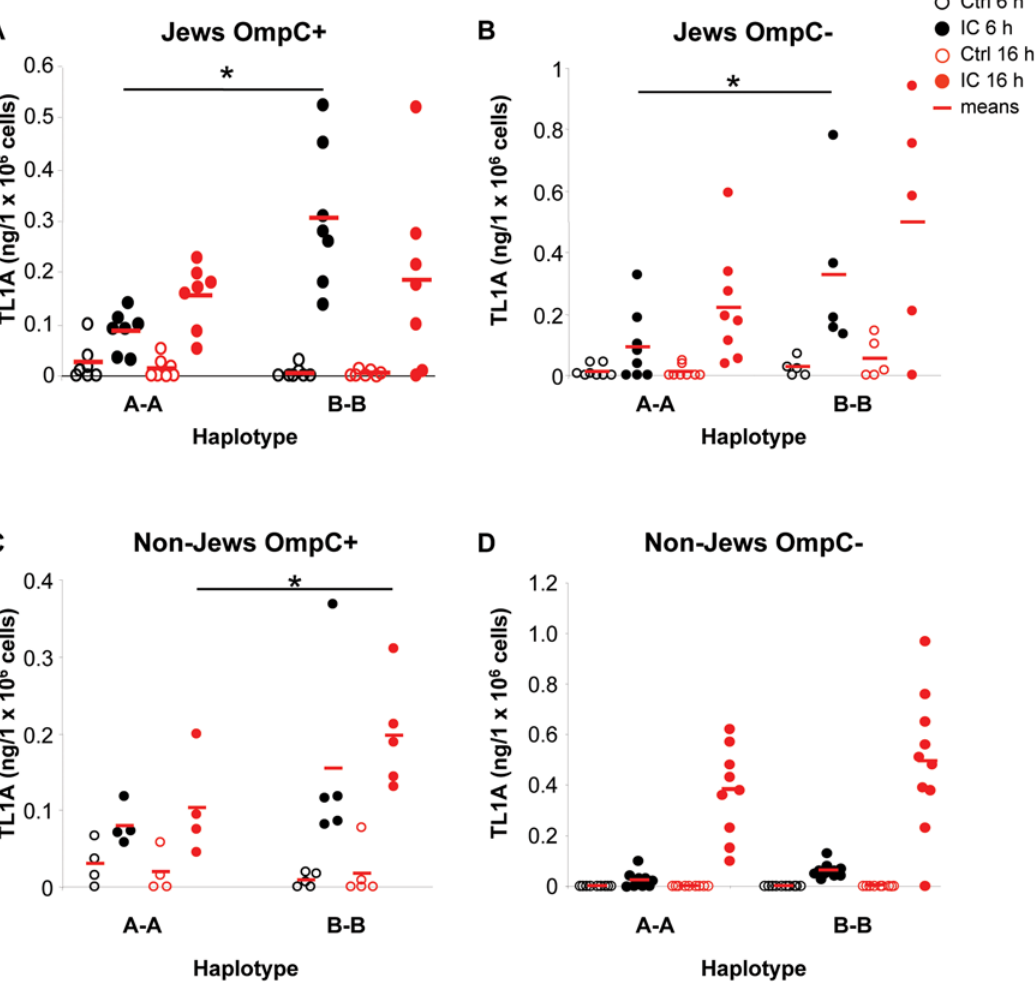
Figure 4. The B risk haplotype is associated with increased TL1A secretion in CD patient subgroups. ( A ) Monocytes from Jewish OmpC + patients homozygous for haplotypes A or B were stimulated with IC for 6 or 16 h (n=7 for haplotype A and haplotype B , *, P # 0.001). Cell culture supernatants were analyzed for TL1A by ELISA. ( B ) Monocytes from Jewish OmpC 2 patients homozygous for haplotype A or haplotype B were stimulated with IC for 6 or 16 h (n=8 and 5 for haplotype A and haplotype B , respectively, *, P # 0.05). ( C ) Monocytes from non-Jewish OmpC + patients with A or B haplotypes were stimulated with IC for 6 or 16 h (n=4 and 5 for haplotype A and haplotype B , respectively, *, P # 0.05). ( D ) Monocytes from non-Jewish OmpC 2 patients with A or B haplotypes were stimulated with IC for 6 or 16 h (n=9 and 10 for A and B ,